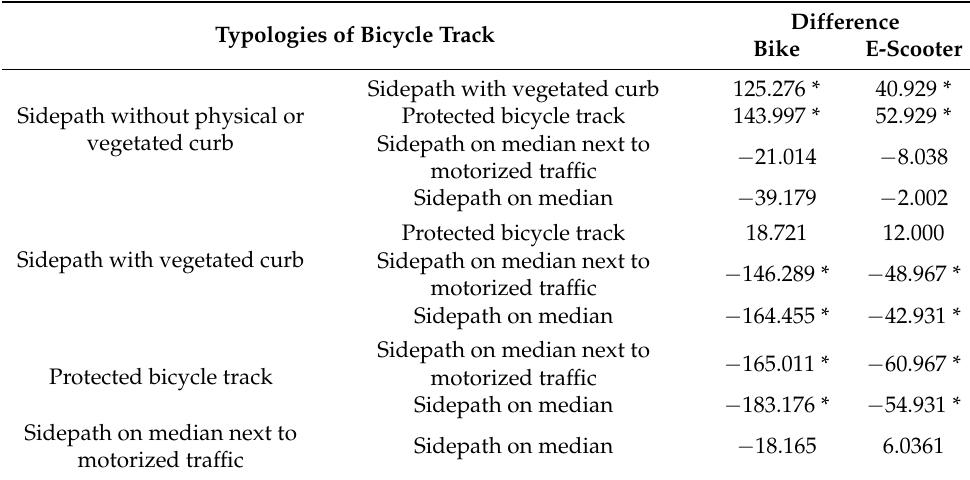
Table 5. Results of the Kruskal–Wallis test in intergroup